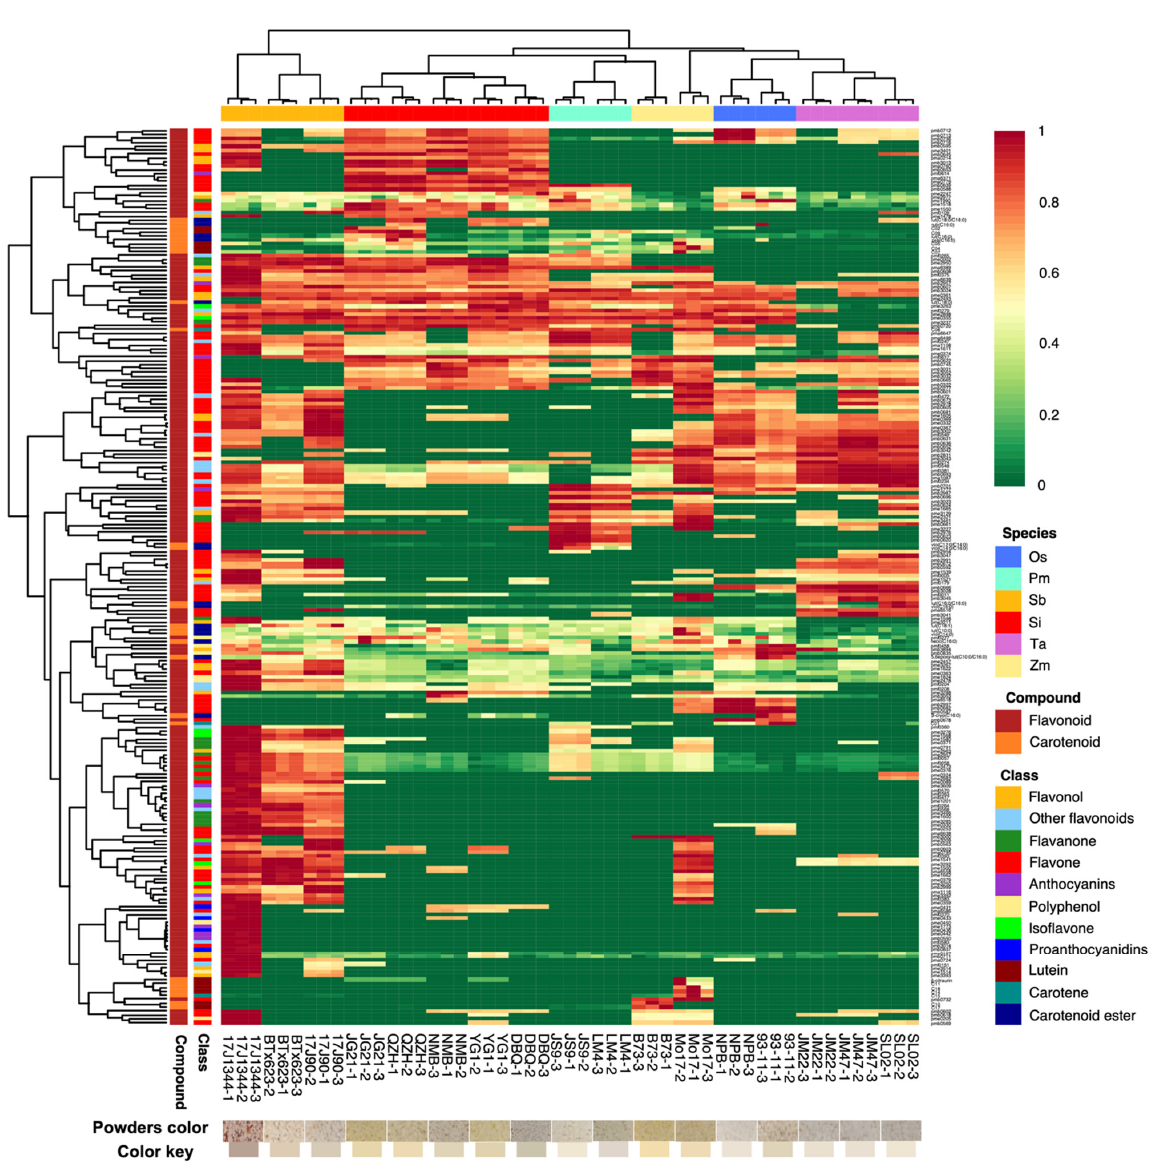
Figure 1. Clustering Heatmap of all flavonoids and carotenoids. The maximum difference normaliza- tion method was used to normalize the metabolite content data. Each metabolite was represented by a row, whereas each sample was represented by a column. Each metabolite’s abundance was indicated by a bar of a specific color. The metabolites that were high and low were represented by different shades of red and green, respectively. The color of the bar changes from green to red as the abundance value increases.